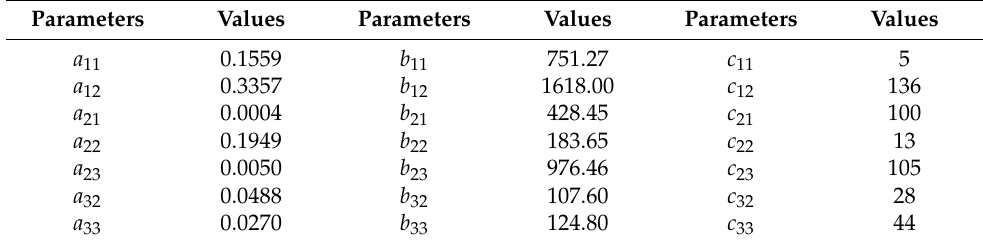
Table 1. Parameters of first-order delay models of the system.